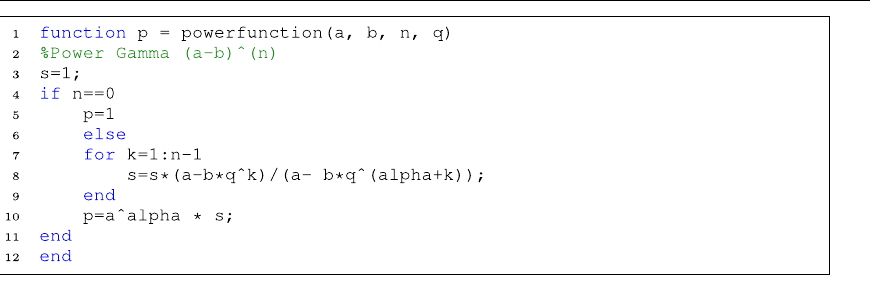
Algorithm 1 The proposed method for calculated ( a – b ) ( α )